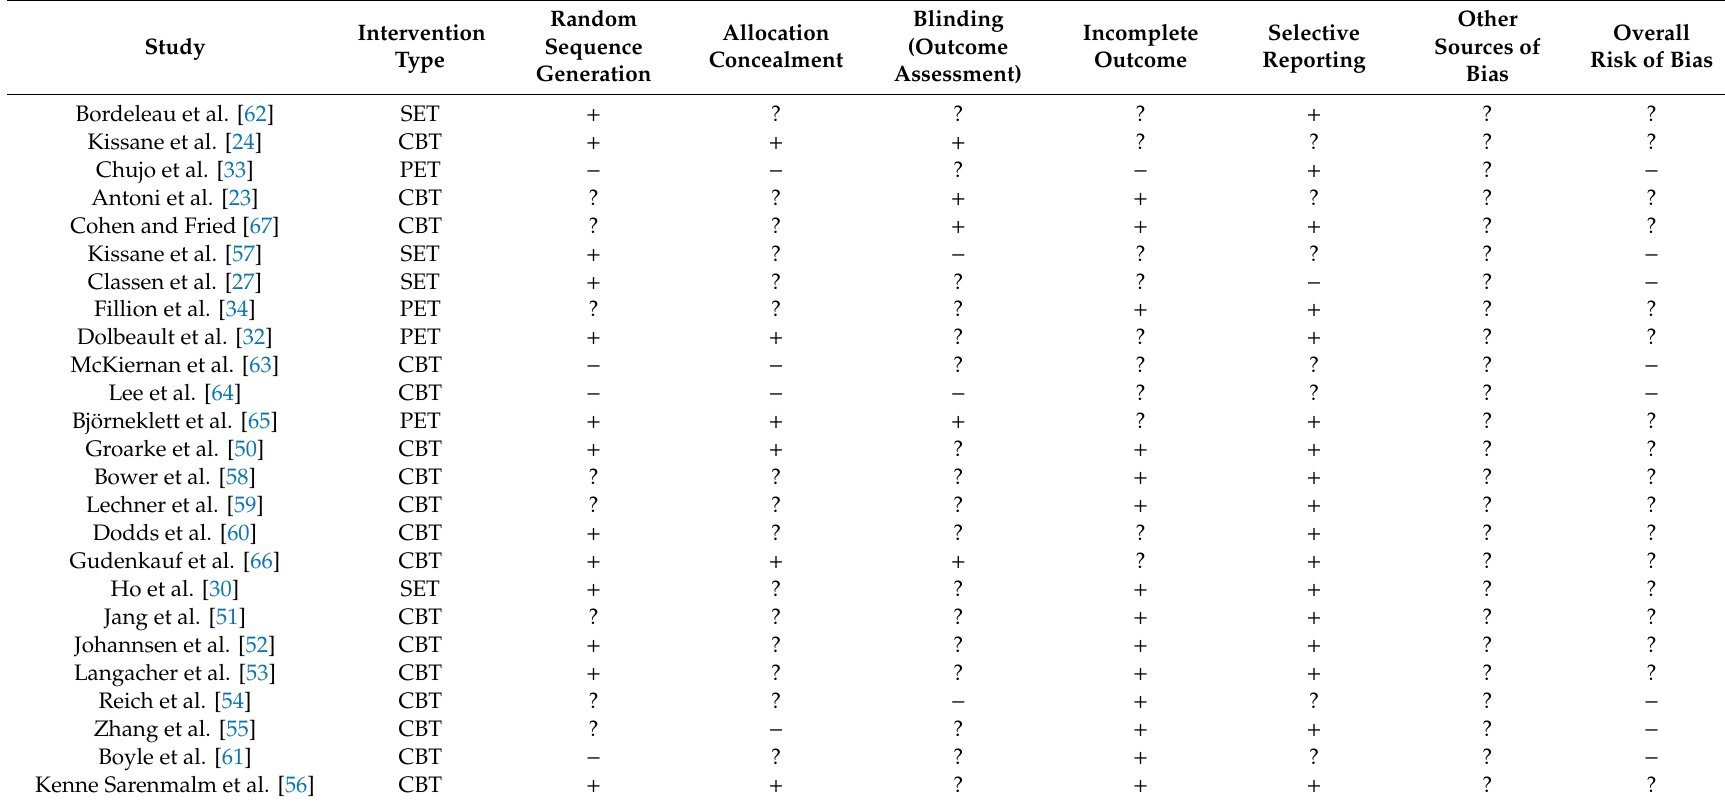
Table 2. Risk of bias assessment for each study selected for the